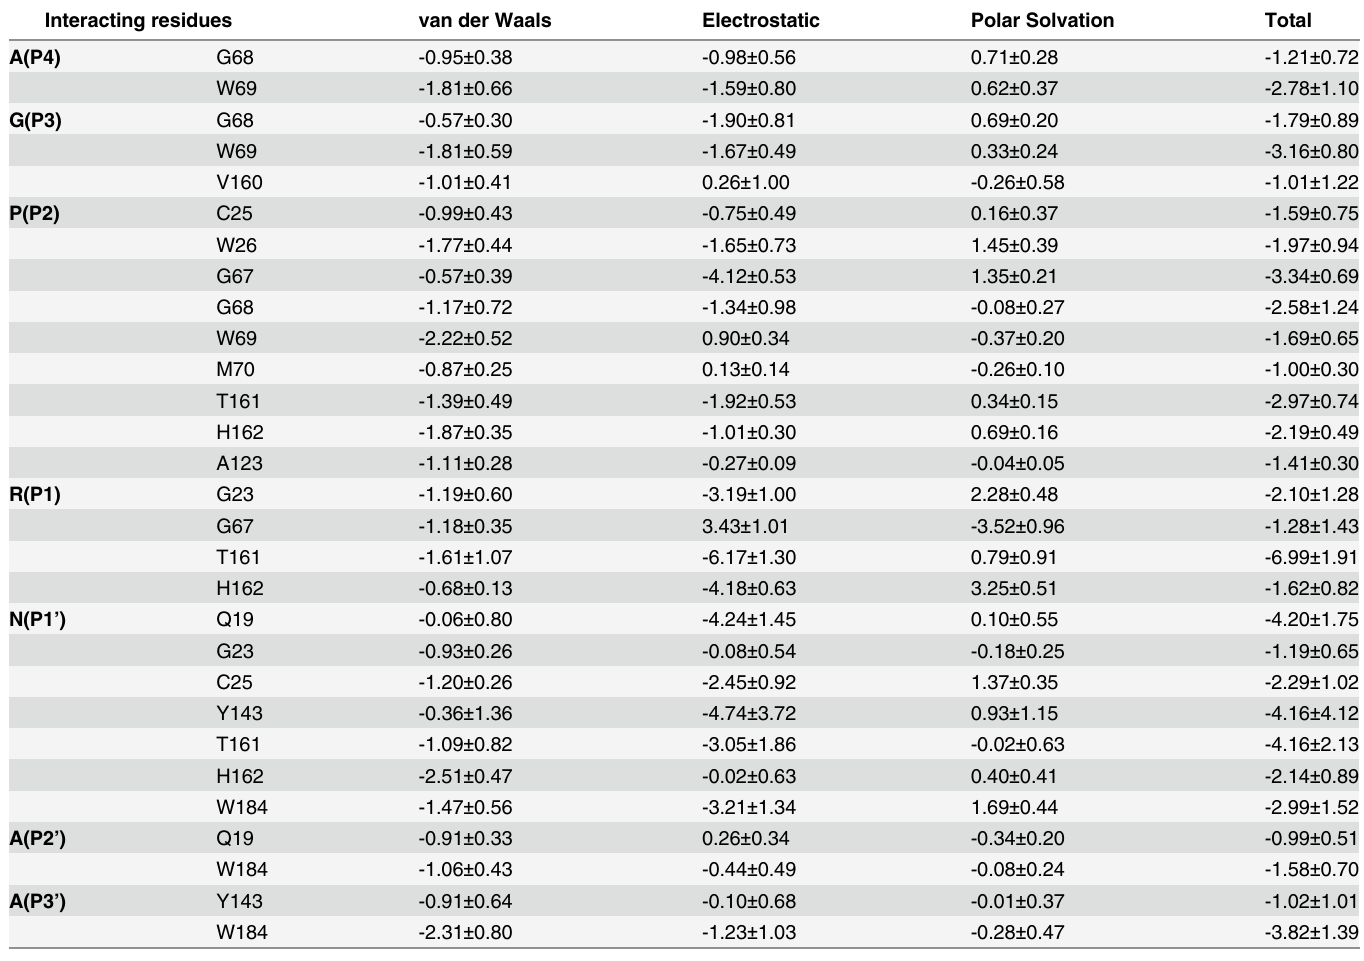
Table 1. Pair-wise energy decomposition values for FhCL3-sustrate complex.